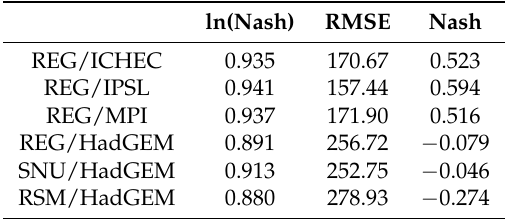
Table 2. Statistical indices for multiple climate models.